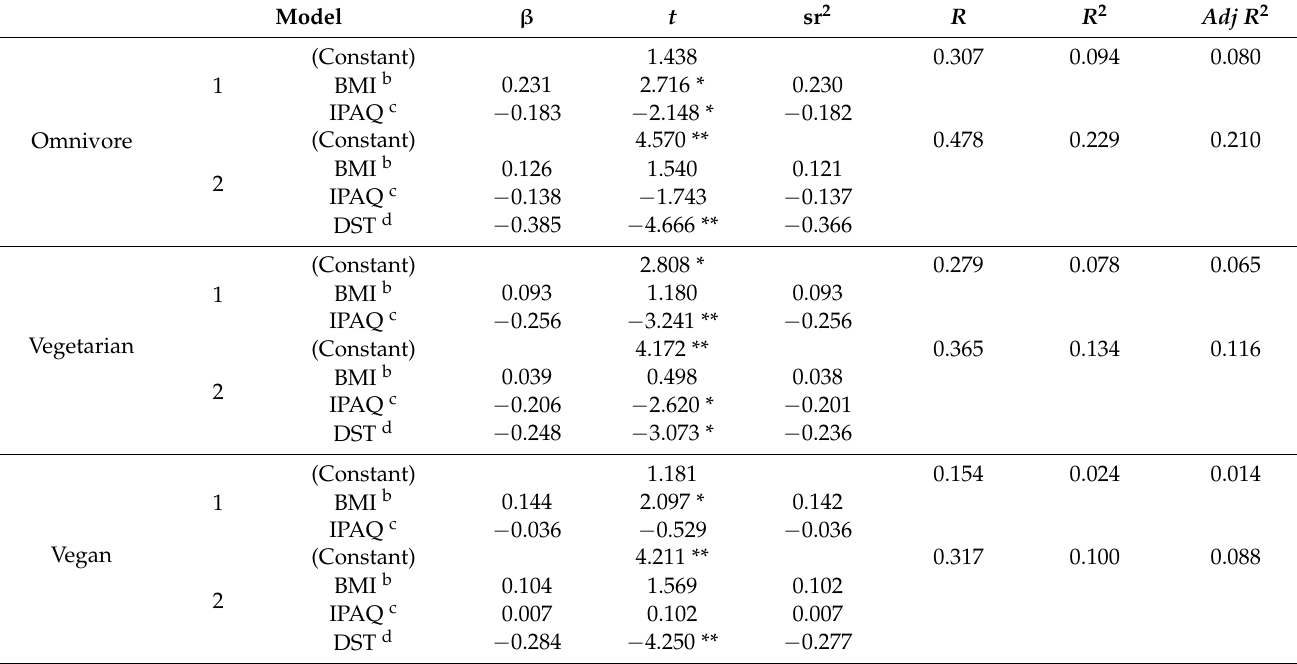
Table 4. Linear regression between an omnivore, vegetarian, and vegan